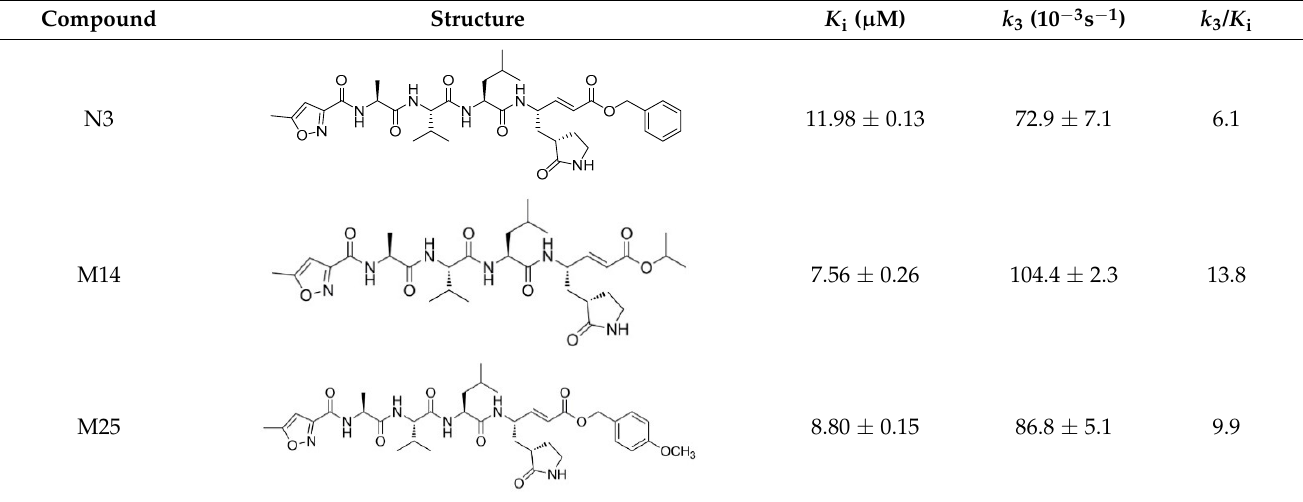
Table 5. Enzyme inhibition data for inhibitors of PDCoV M pro .